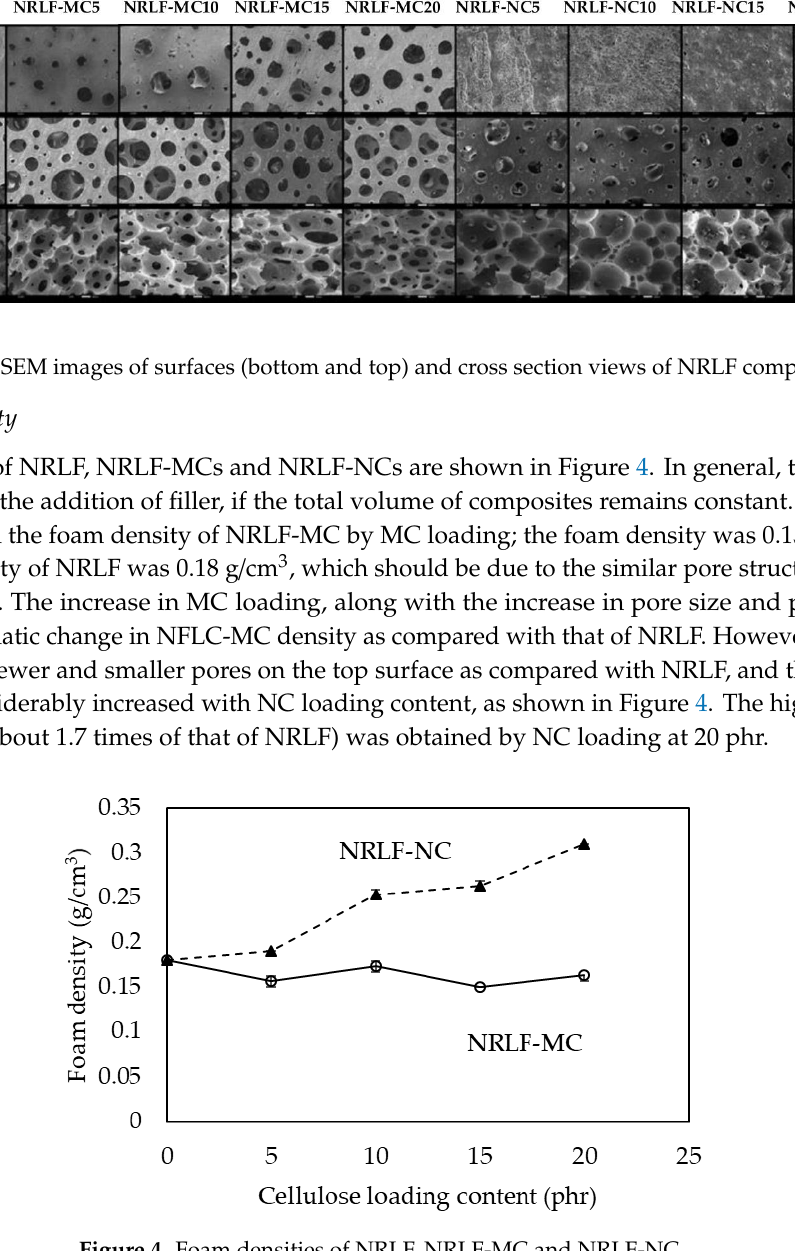
Figure 4. Foam densities of NRLF, NRLF-MC and NRLF-NC. 262